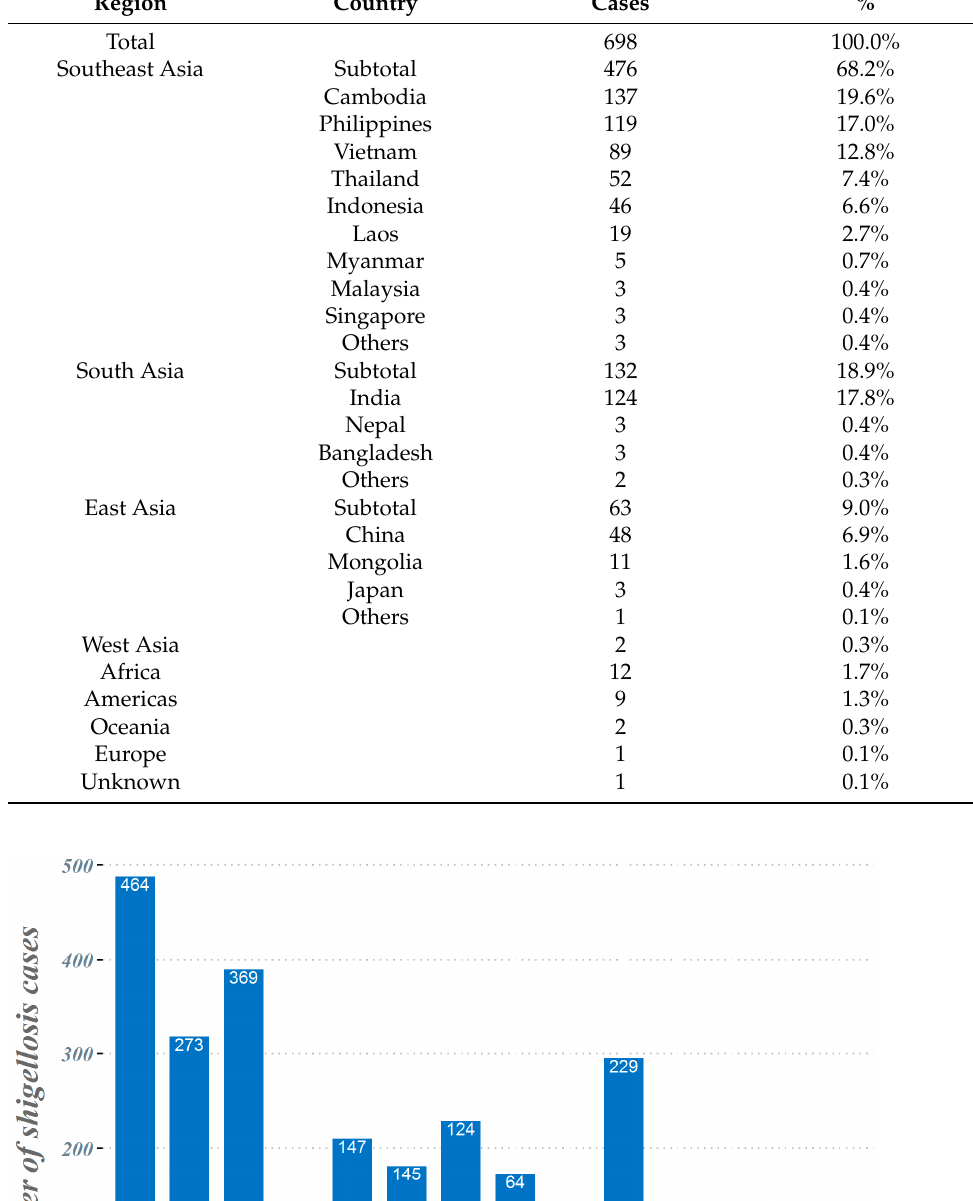
Table 1. Distribution of imported cases of shigellosis across travel destinations, 2004–2017.